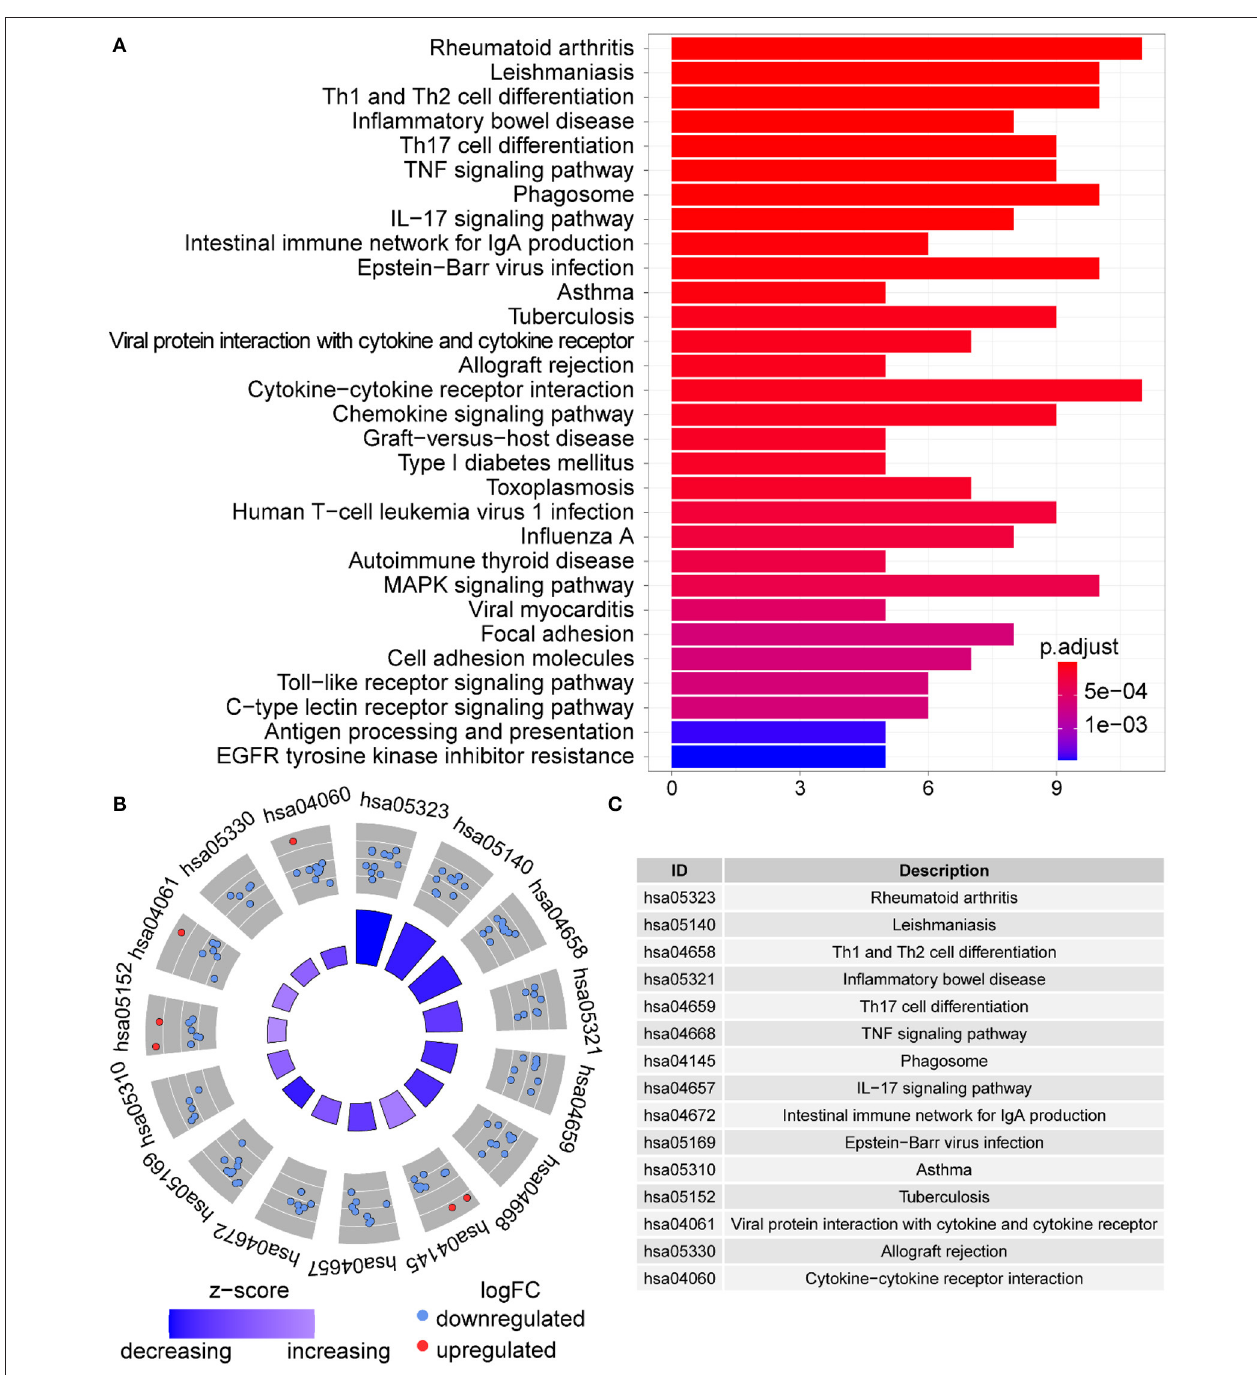
FIGURE 4 | KEGG analysis of the DE-IGs between normal liver and BA. (A) The 30 most significantly enriched KEGG pathways are displayed in the barplot. The length of the bar represents the number of genes enriched and the color represents the correlation. (B) The circle of KEGG enrichment analysis. Each dot in the circle represents a gene and the outer circle reflects the enrichment of the DE-IGs in different signaling pathways. The inner circle represents the Z-score, the color depth corresponding to the Z-score. Higher Z-score indicates a higher expression of the DE-IGs in enriched pathways. (C) The table annotates KEGG pathways.